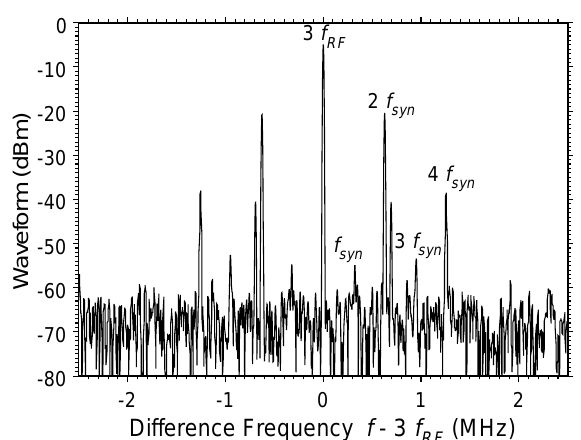
FIG. 3. Rich harmonic content of beam, showing multiple syn- chrotron sidebands around 3 f rf . This spectrum is measured near the peak of the first blowup of the quadrupole mode in Fig. 2. The dominant quadrupole mode appears to be split; the signal associated with the first blowup has shifted in frequency after growing in amplitude, while the signal associated with the sec- ond blowup begins to